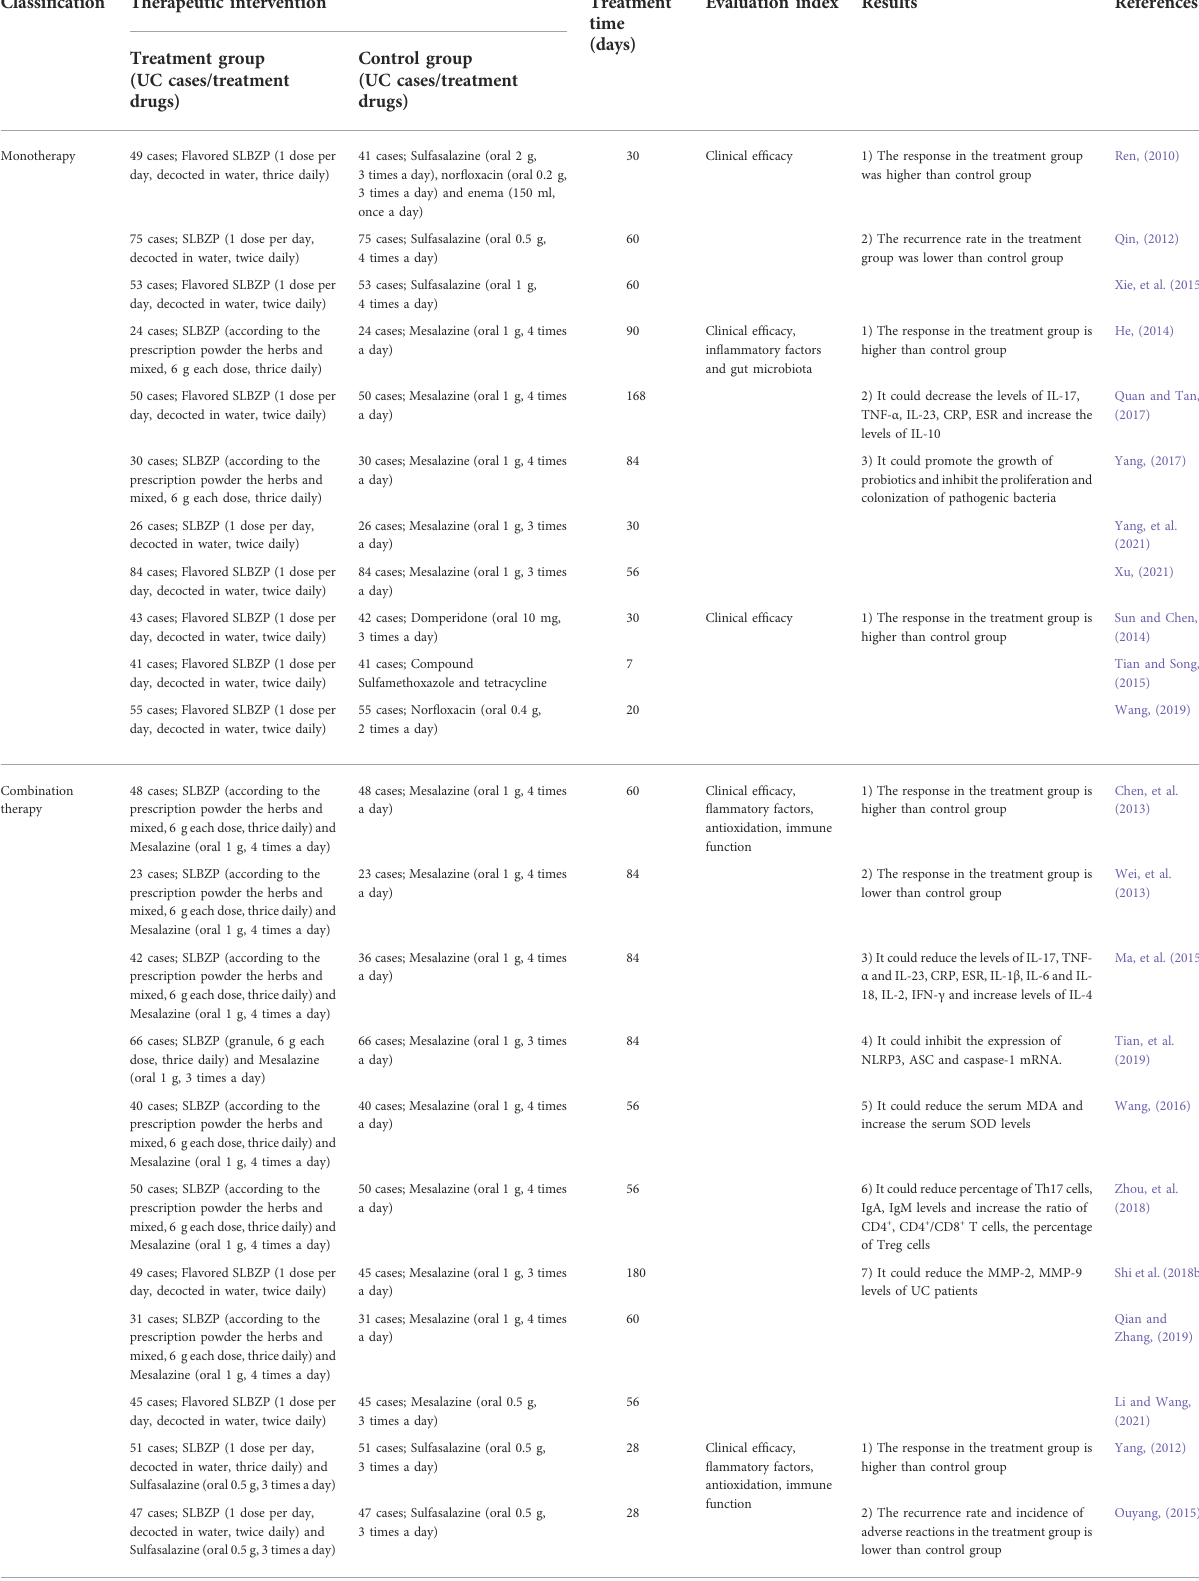
TABLE 1 Overview of clinical studies of